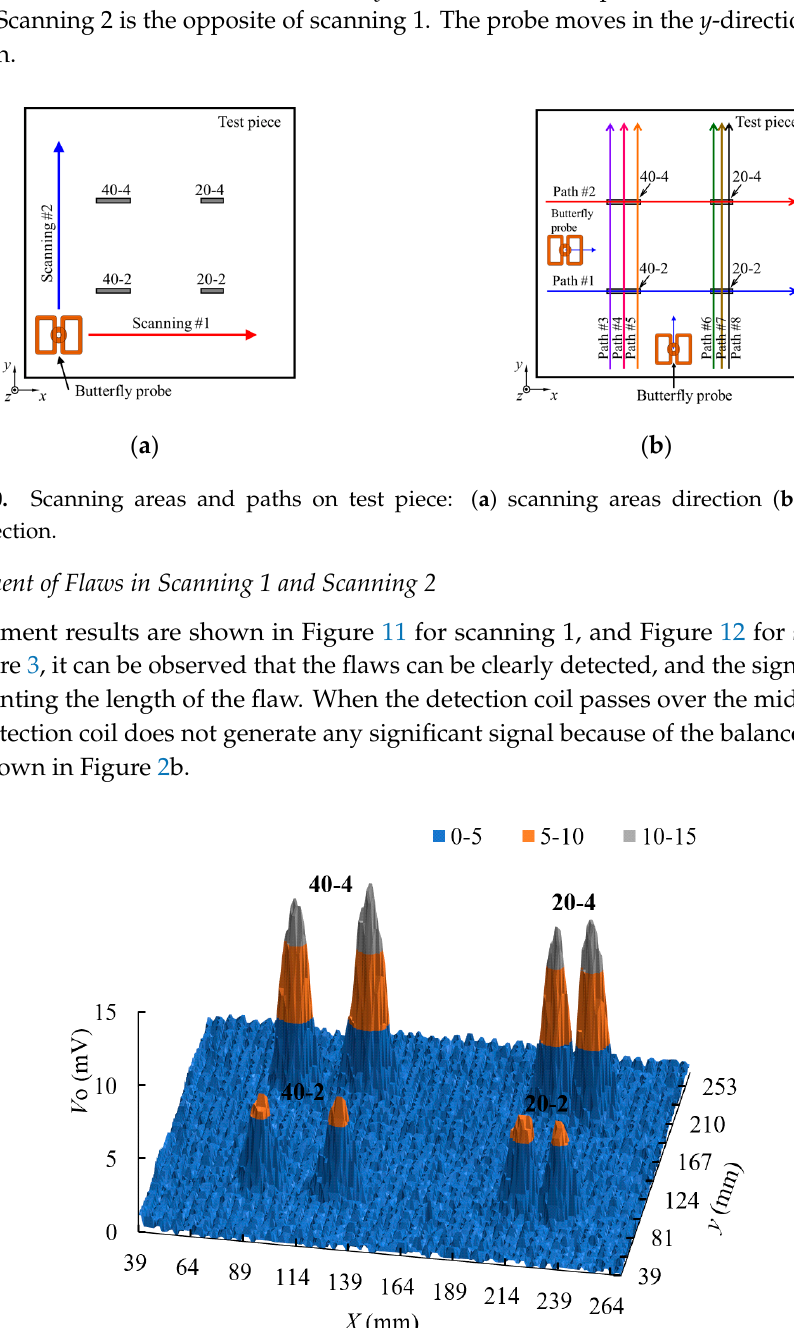
Figure 12. Measurement results of the butterfly probe with scanning 2 in x-y area. 3.2. Measurement Results along Paths #1 and #2 with Scanning 1 The butterfly probe moves along paths #1 and #2, as shown in Figure 10; measurement results are shown in Figure 13. Figure 13. Measurement results of the butterfly probe along paths #1 and #2.